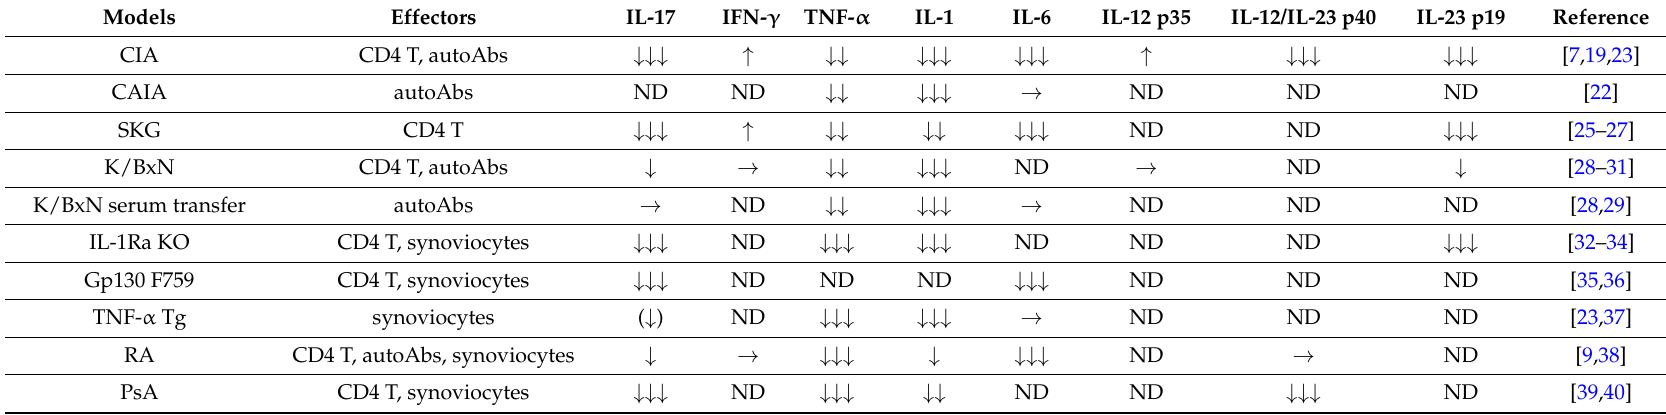
Table 1. Regulation of the development of arthritis by the inhibition of cytokines in animal models of rheumatoid arthritis (RA) and in human RA and psoriatic arthritis